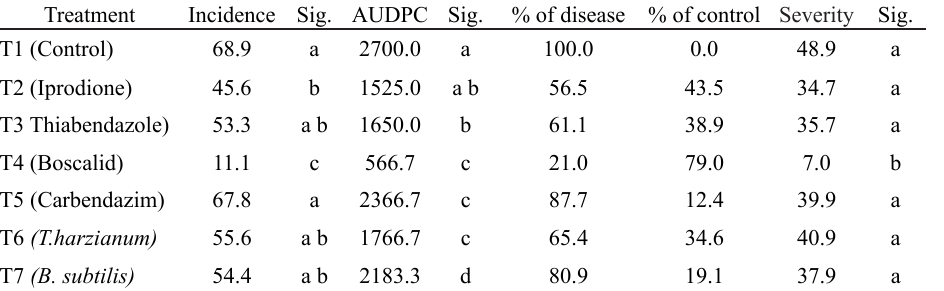
Table 6: Percentage test for disease incidence, AUDPC, severity and control percentage of treatments, on field with broccoli addition. (alfa=0.05). Treatment